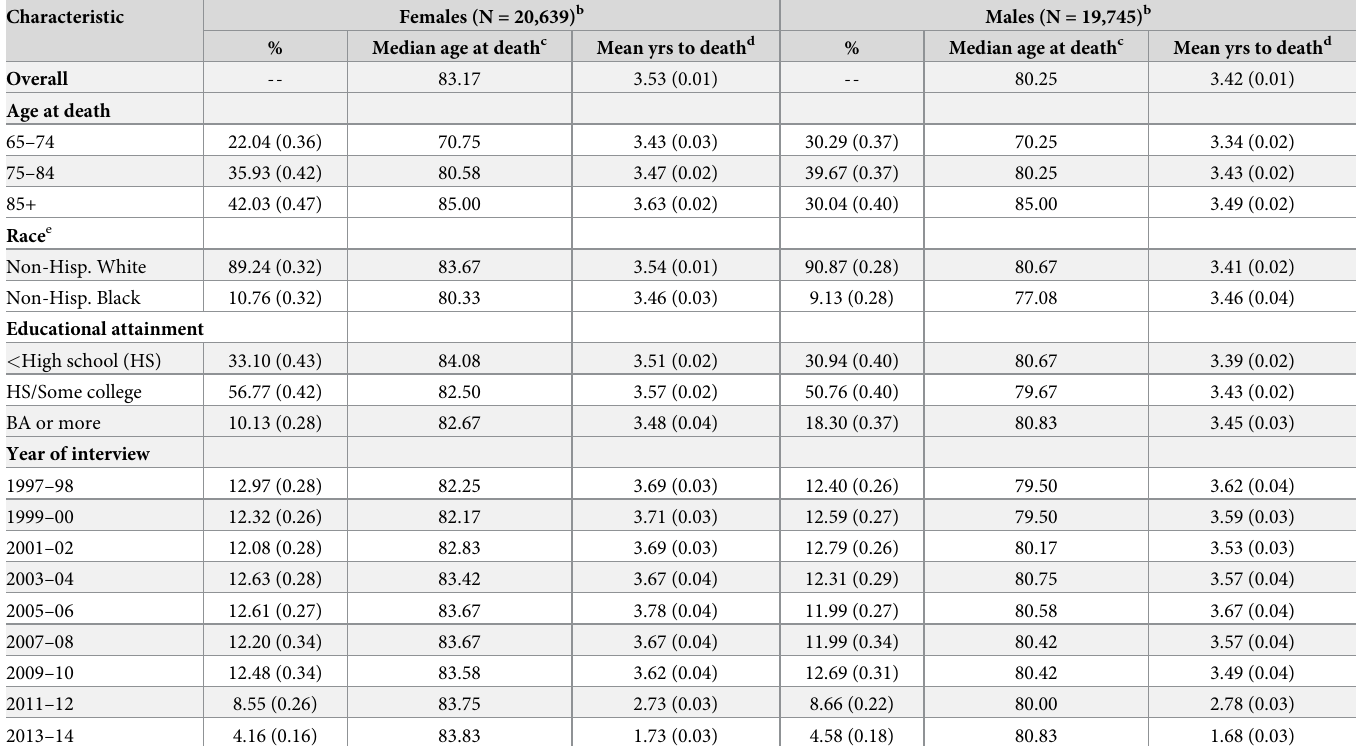
Table 1. Characteristics of adults 65+ dying within 6 years of NHIS interview, 1986–2014 a . Standard deviation in parentheses.